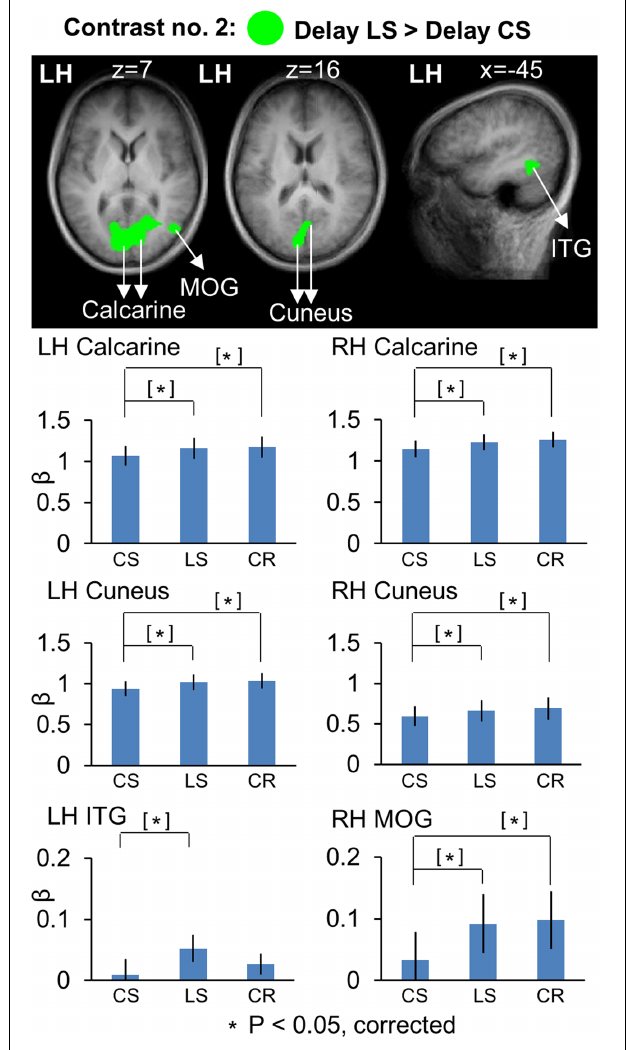
FIGURE 4 | Voxelwise statistical map obtained with the RFX GLM and activation levels for each area using Contrast no. 2 [Delay LS > Delay CS]. Top panel: activation map overlaid on the averaged anatomical image from all participants. Bottom panel: bar graphs show the β weights for the three tasks in each area. Legends as in Figure 2